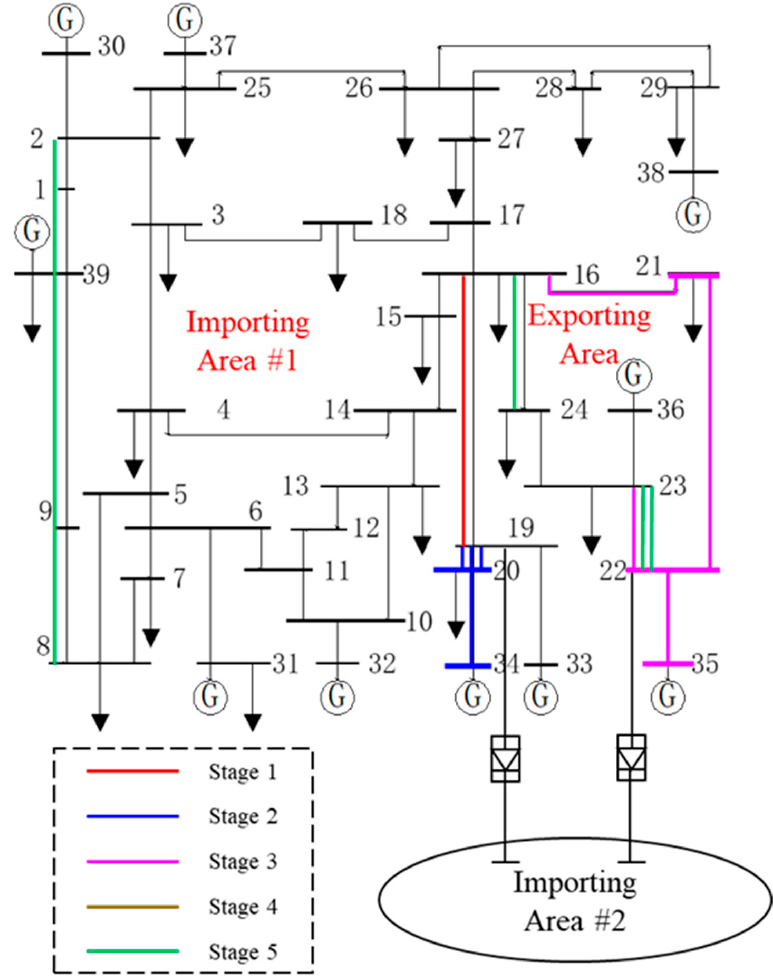
Figure 4. The transmission expansion planning scheme under the conventional model.